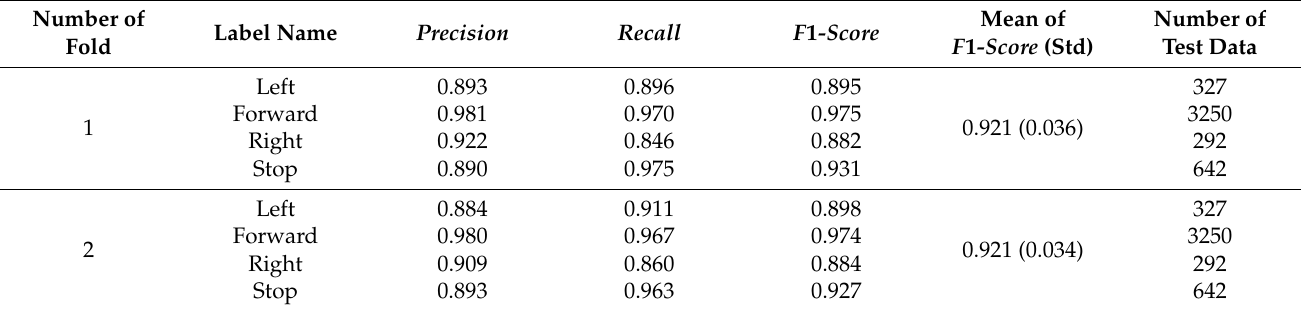
Table 3. Raw data of the scores in 1DCNN-LSTM model (time step = 3 s, data sets = head +